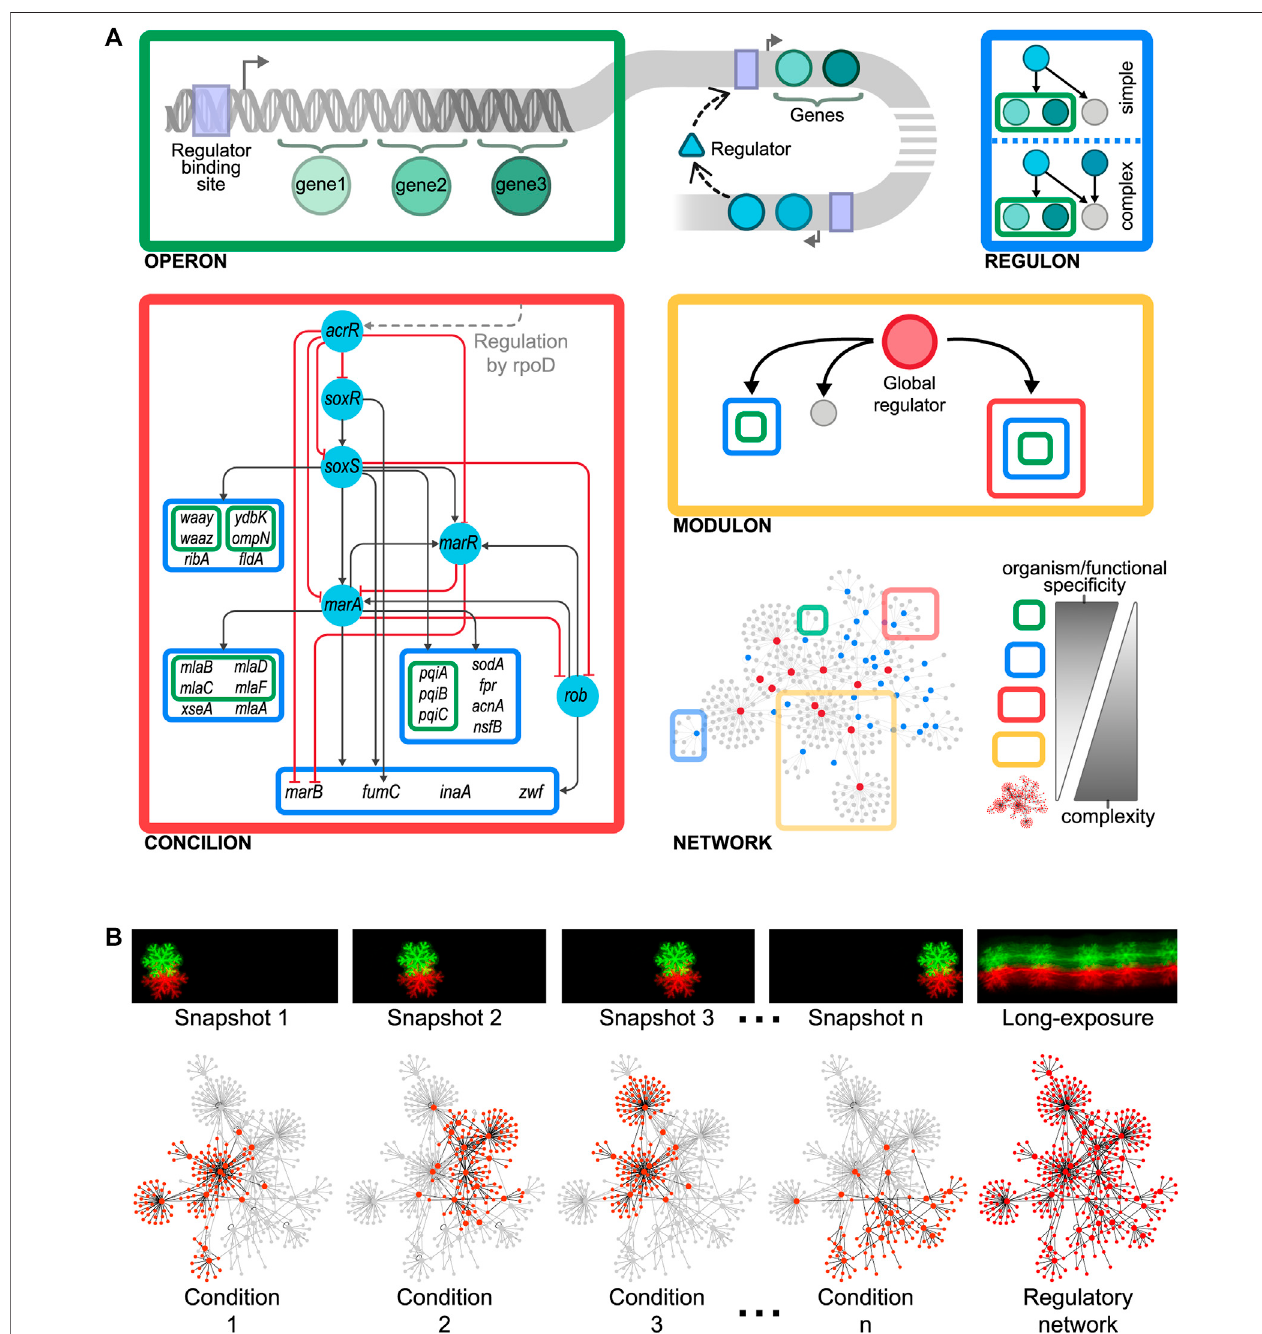
FIGURE 1 | (A) Organizational layers shaping the modular hierarchy of the gene regulatory organization as gene < operon < regulon < concilion < modulon. A biological example of the here-proposed concilion is the “ response to multiple stresses ” module found in E. coli (Escorcia-Rodriguez et al., 2020). The grey dashed line showsthat acrR isgloballycontrolledby rpoD ,whichalsocontrolsotherconcilionsandregulons( Figure2A ).ThemasterregulatorsinthishierarchyareSoxRandSoxS, which respond to oxidative stress through sensing superoxide and nitric oxide. SoxS, MarA, and Rob bind as monomers to the same DNA site, a 20-bp degenerated sequence known as Mar/Sox/Rob box. The differential regulation of these genes could be archived by the degeneracy of their DNA binding sites or by the regulators ’ concentration and the different af fi nities for the Mar/Sox/Rob box (Martin et al., 1999; Chubiz et al., 2012). The presence of several paralogous regulators (members of the AraC/XylS family) recognizing the same DNA binding site allows to archive a differential response by activating the same genes in response to different environmental cues (Martin et al., 2008). This phenomenon, known as commensurate regulon activation, enables bacteria to mount a proportionate response of the marA / soxS / rob regulon to the stress signal, keeping the number of activated genes to the minimum necessary to cope with prolonged stress (Martin et al., 2008; Wall et al., 2009). This balances the energetic cost of gene expression against the intensity of the stress. (B) Curated reconstructed regulatory networks merge many individual condition-speci fi c subnetworks (such as picture snapshots) into a single network model thus capturing all the possible dynamic trajectories (such as a long- exposurephoto does).Consequently,curatedregulatorynetworksarenotstaticrepresentationsofregulation,astheyembed allthepotential regulationsthatcanoccur thus constraining the large number of organizations a regulatory network could potentially